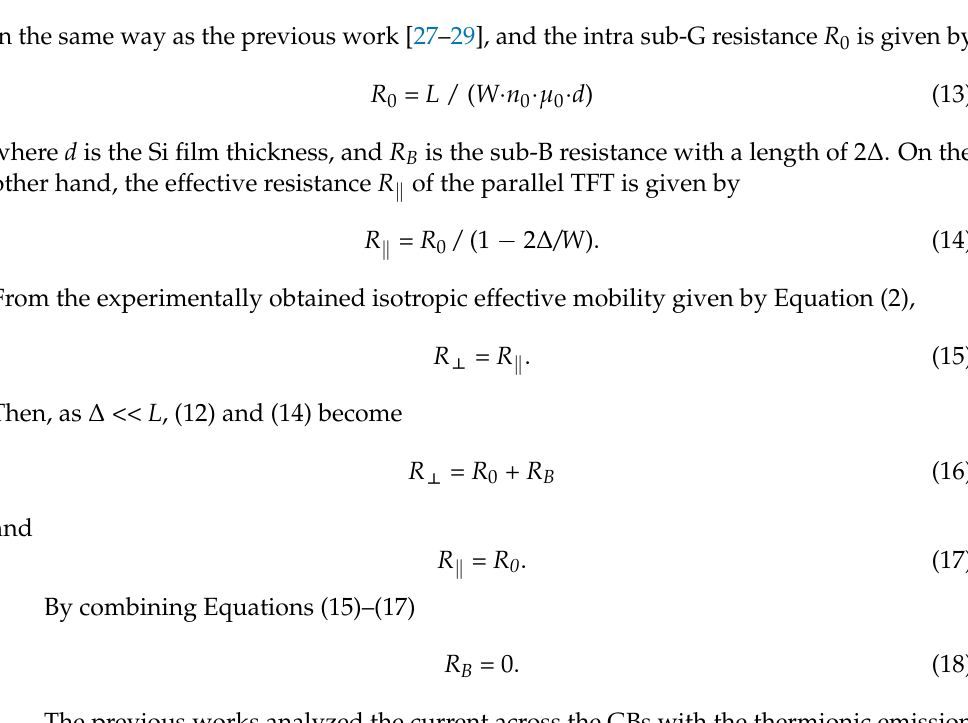
Figure 6. Optical micrograph of the TFT fabrication: ( a ) after the island patterning and ( b ) after the gate patterning. The channel length was 10 μ m with a width of 5 μ m for both parallel and perpen ‐ dicular TFTs.